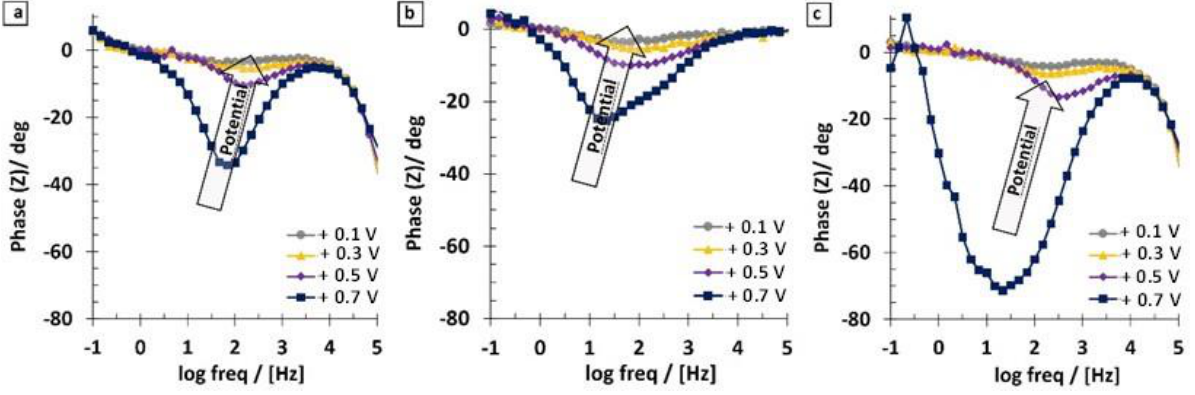
Figure 6. Bode-phase spectra at positive potentials for ( a ) Al 1.0 , ( b ) Al 0.8 , and ( c ) Al 0.6 . Based on the visual observations of the impedance spectra, the corrosion process pa-